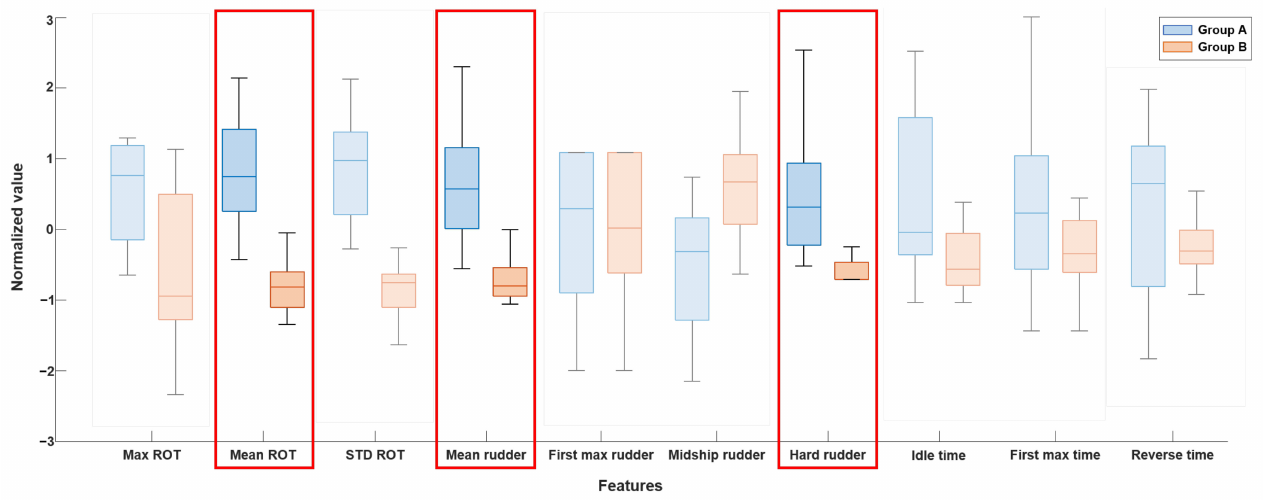
Figure 7. Selected features.